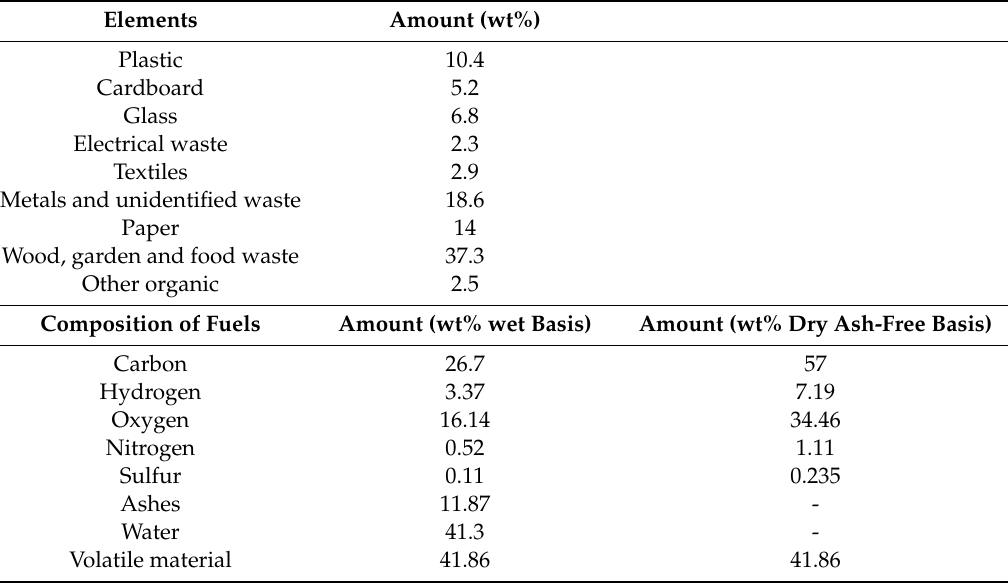
Figure 9. Mechanical biological chemical treatment (MBCT) of Municipal Solid Waste (MSW), with mass balances between input and output,), adapted from [84]. Table 5. Data of Municipal Waste, from